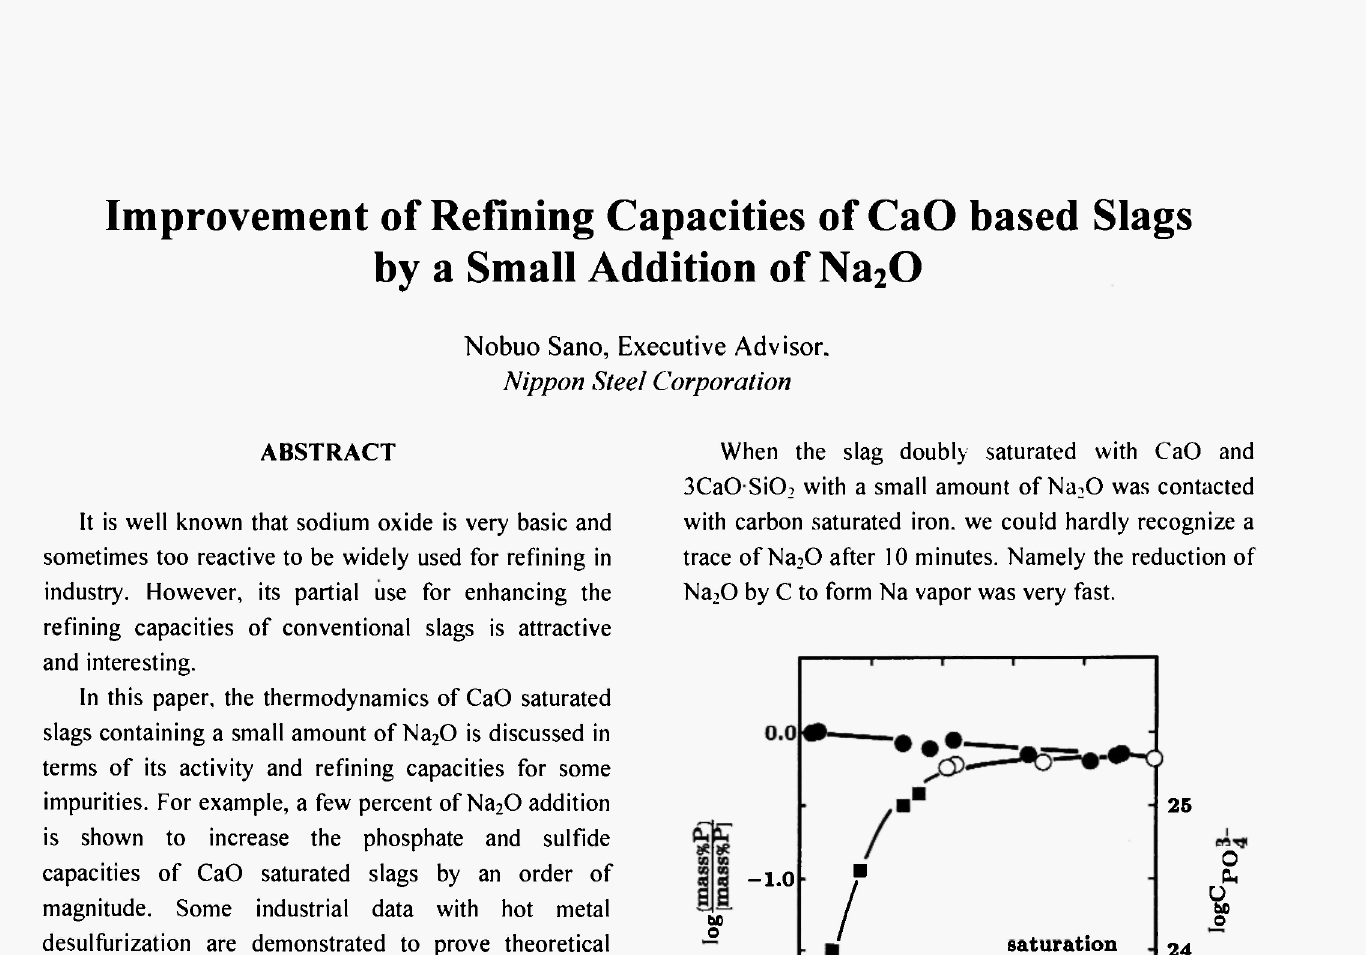
Fig. I: Composition dependence of Cpo 4 3 " at 1573Κ for the Ca0-CaF 2 -Si0 2